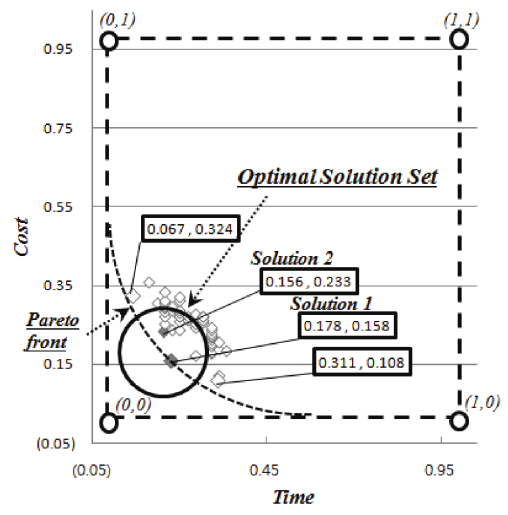
Fig. 10. 50 highly ranked populations, the Pareto front, and the optimal solution set in the standardized coordinate axis